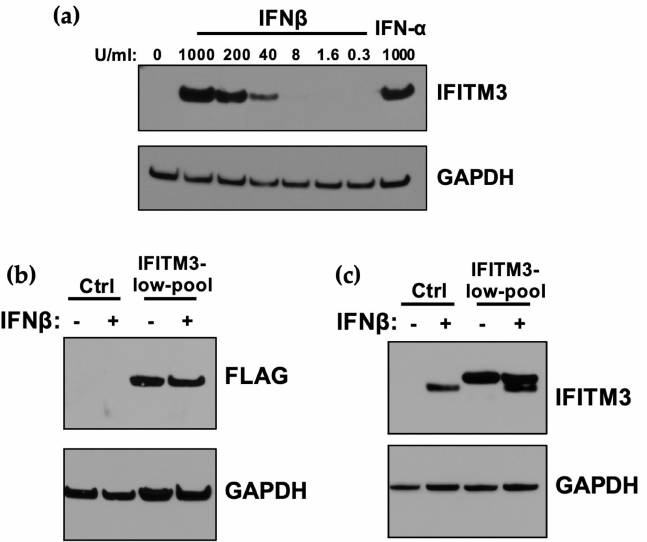
Figure 3. Expression of IFITM3 in A549 cells transduced with exogenous IFITM3 compared to after IFN-I-induction. ( a ) Western blot analysis of IFITM3 expression in A549 cells pretreated with increasing concentrations of IFN β and 1000 U / mL IFN α for 24 h. The concentration of IFN β is indicated above each lane. ( b ) Western blot analysis of IFITM3-FLAG expression using an anti-FLAG antibody in IFITM3-low-pool A549 cell lines. Control cells were either untreated or treated with IFN β (1000 U / mL) for 24 h. ( c ) Western blot analyses of expression of IFITM3-FLAG protein compared to endogenous IFITM3 using an anti-IFITM3 antibody. Control cells were either untreated or treated with IFN β (1000 U / mL) for 24